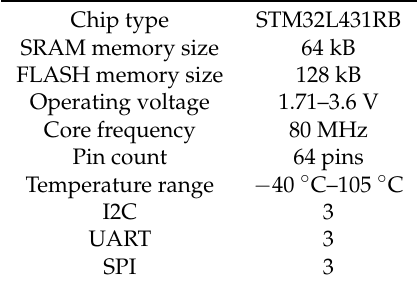
Figure 6. Block diagram of the processor module. Table 1. Basic properties of the STM32L431RB